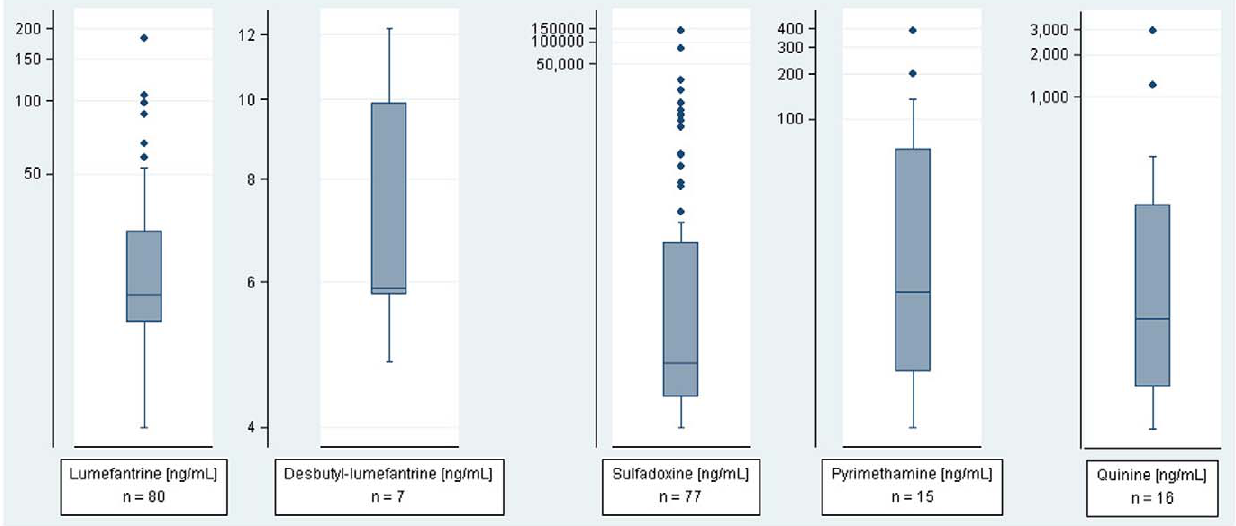
Figure 2. Residual plasma concentrations of antimalarials found prior to treatment in 148 malaria patients. Number of patients (n), median, 25 th and 75 th percentile, lower and upper adjacent values, and outside values are shown for lumefantrine, desbutyl-lumefantrine, sulfadoxine, pyrimethamine and quinine on a logarithmic scale [ng/mL].